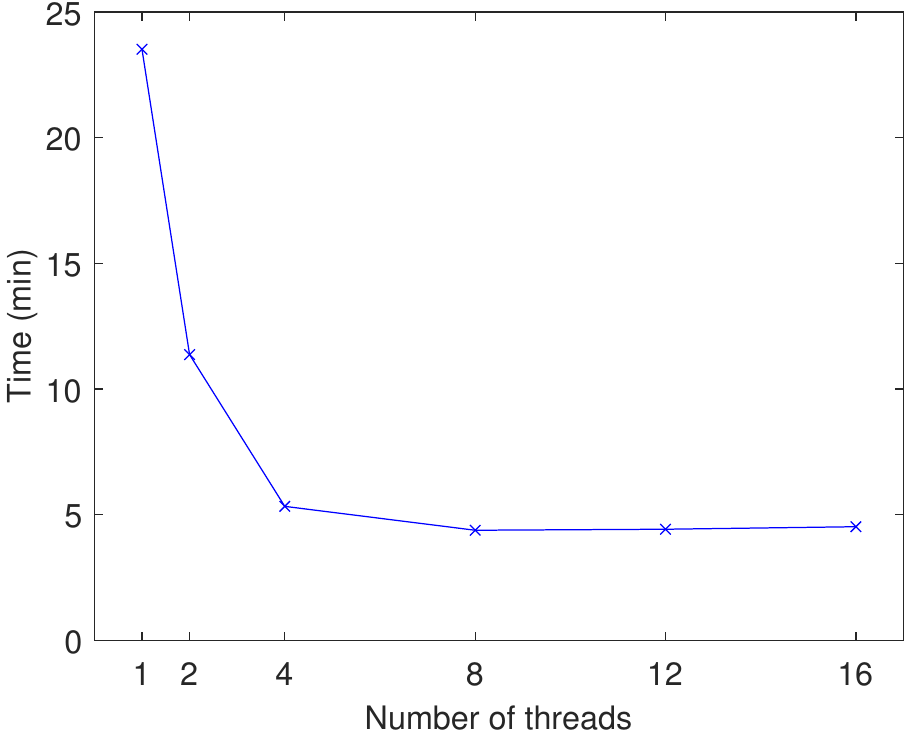
Figure 5. Running time for the number of